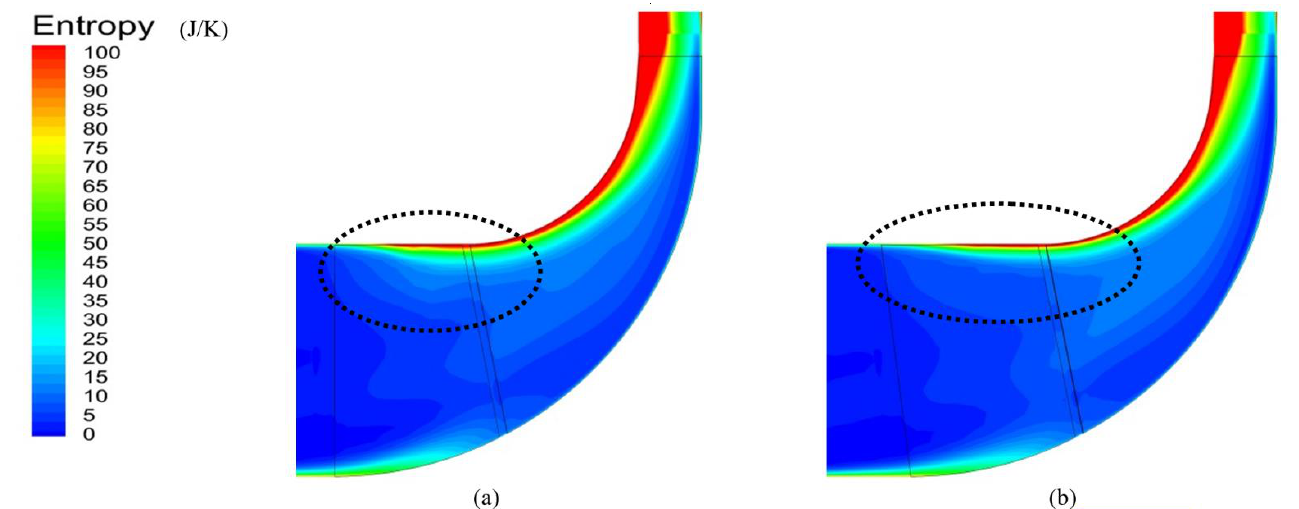
Figure 23. Comparison of the entropy distribution at the meridional plane for different swept impellers (P.E. point). ( a ) Baseline tandem impeller, and ( b ) forward swept tandem impeller (F = 4 mm).